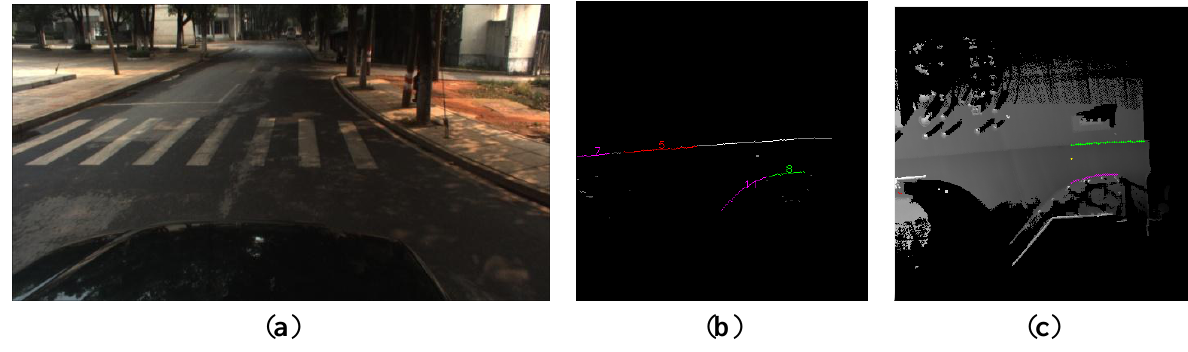
Figure 12. The result of the curb detection. ( a ) Scene 2. ( b ) The data cluster results of the curb candidate points. ( c ) The final curb detection results in the local DEM.